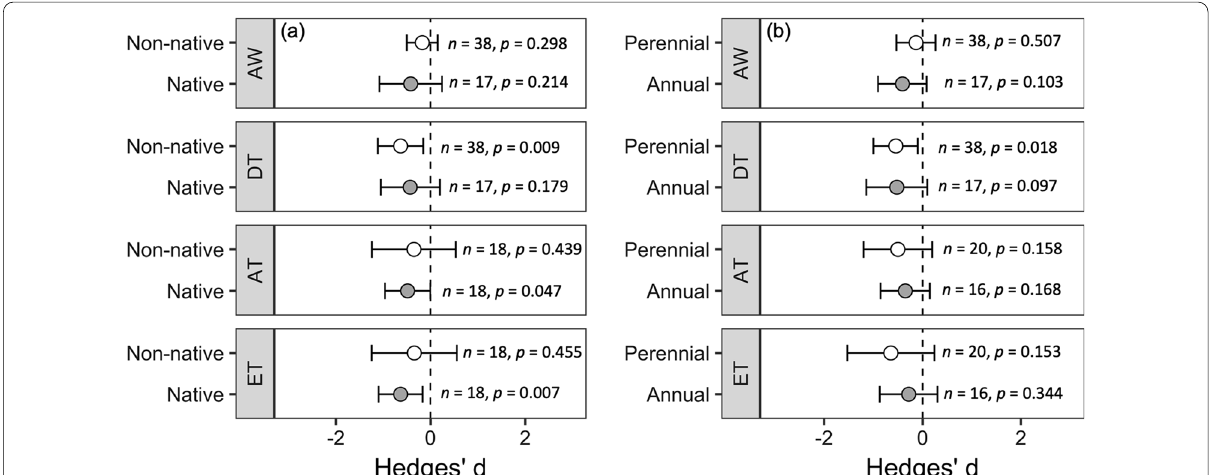
Fig. 4 Effects of temperature and rainfall on PSFs depending on origin of species ( a ) and life cycle ( b ). Mean PSFs effect size is presented with 95% CI. Mean PSFs effect size is significantly different from zero if the corresponding CIs do not overlap with zero (dashed line). n represents the total number of observations used during analysis and p indicated whether mean PSFs effect sizes were significantly different from zero. Hedges’ d : 0 for no effect, 0.2 for small ( 20%), 0.5 for medium ( 50%), 0.8 for large ( 80%) and > 1.0 (> 100%) for strong large negative effects, − − − − − − − respectively. AW: ambient water; DT: drought; AT: ambient temperature, ET: elevated temperature